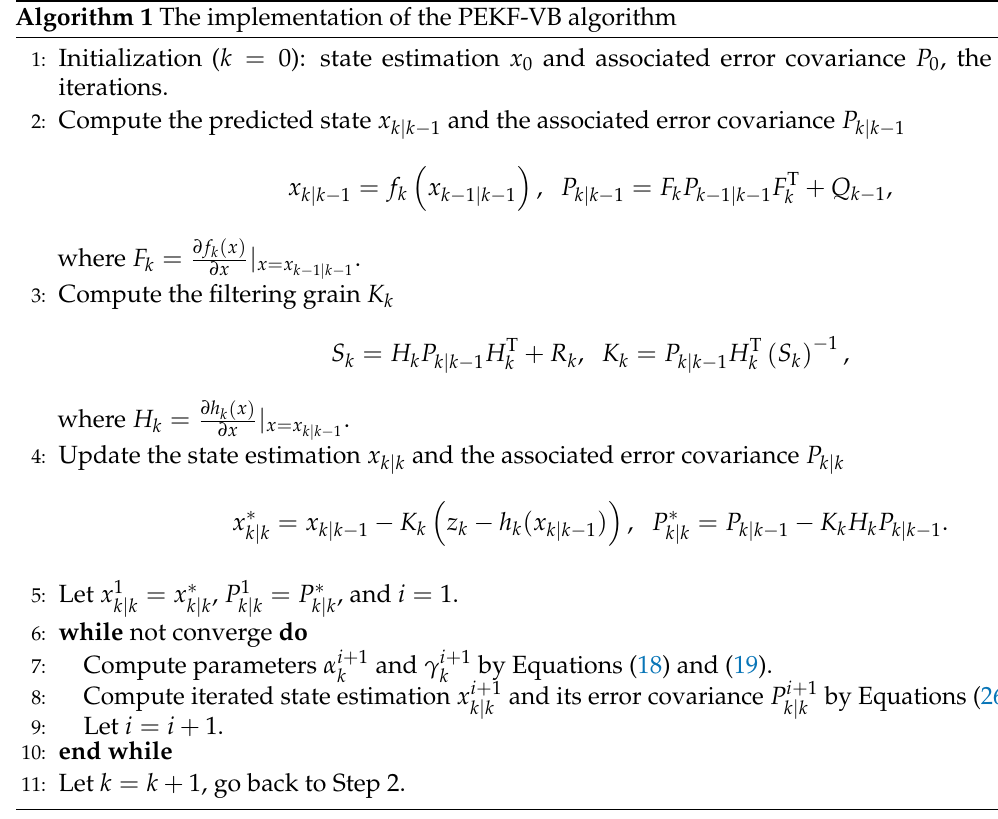
Algorithm 1 The implementation of the PEKF-VB